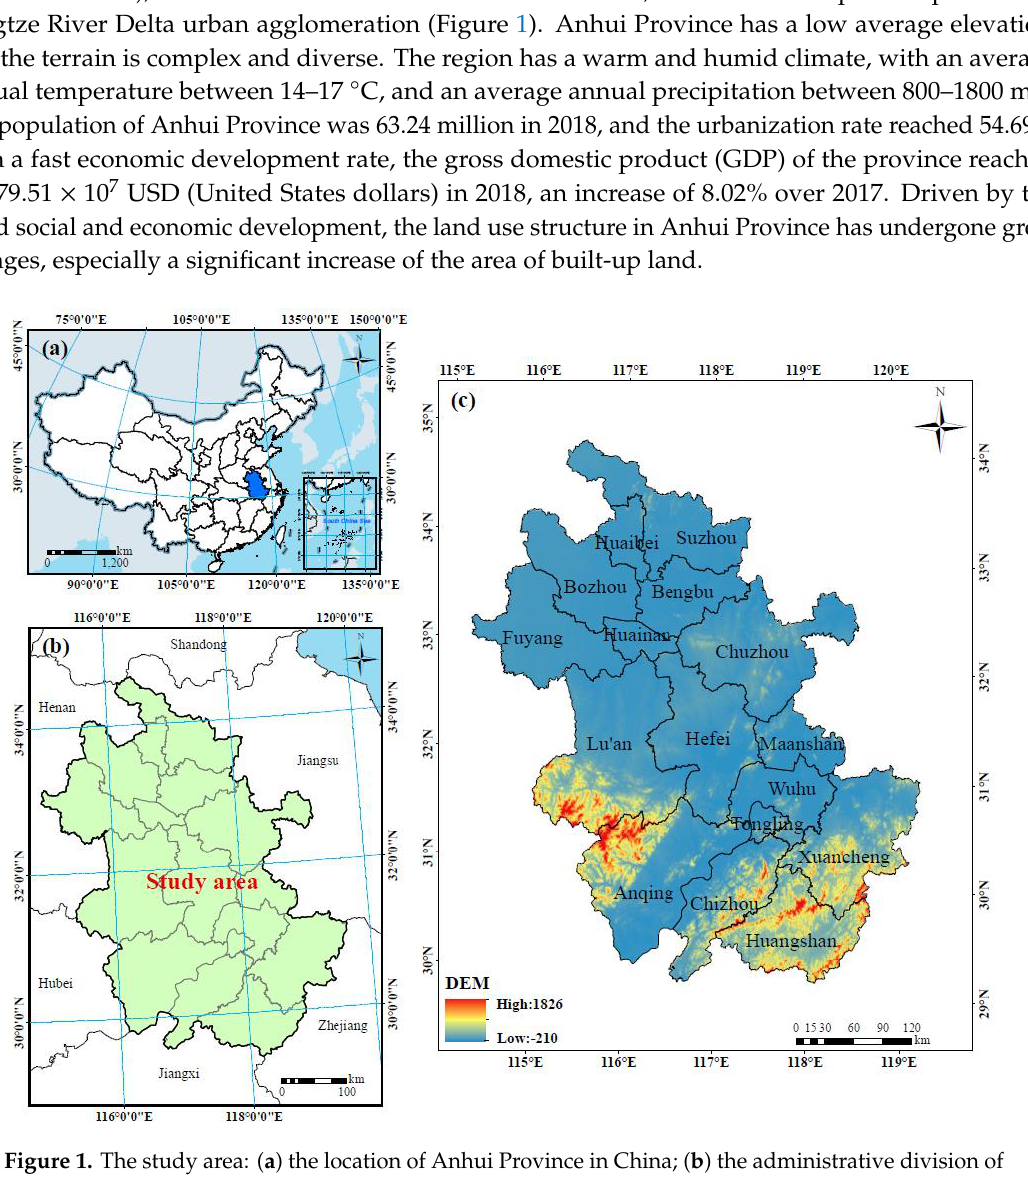
Figure 1. The study area: ( a ) the location of Anhui Province in China; ( b ) the administrative division of Anhui Province; ( c ) the digital elevation model (DEM) of Anhui Province.